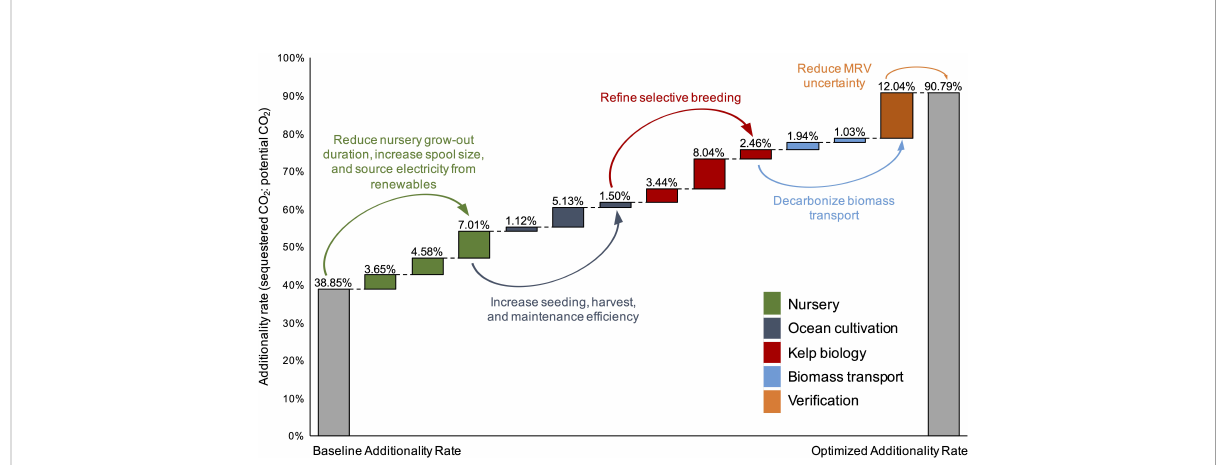
FIGURE 8 Optimization analysis in which the values for 12 key parameters were sequentially changed to either the minimum or maximum value identi fi ed in literature reviews that improved (increased) the additionality rate (AR) of the baseline farm (ratio of annual C credits produced: tCO 2 eq sequestered annually, expressed as a %). The changes were then combined to calculate an “ optimized ” AR as a result of process improvement ( gray column ). Colors correspond to the 5 areas of potential improvements: nursery production ( green ), ocean cultivation ( dark blue ), kelp biology ( red ), biomass transport ( light blue ), and veri fi cation ( orange ).